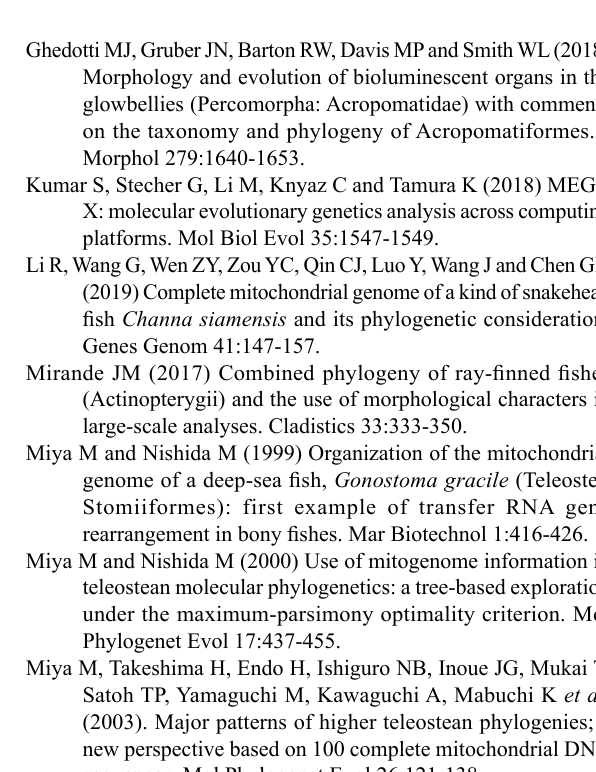
Figure 3 – Comparison of the topologies of the present and previous classifications. (Left) Edited topology of the classification presented by Betancur-R et al . (2017). (Right) Topology of the BI tree constructed in the present study. Bold lines indicate the highly reliable branches (support value > 50% in left and support value > 90% in